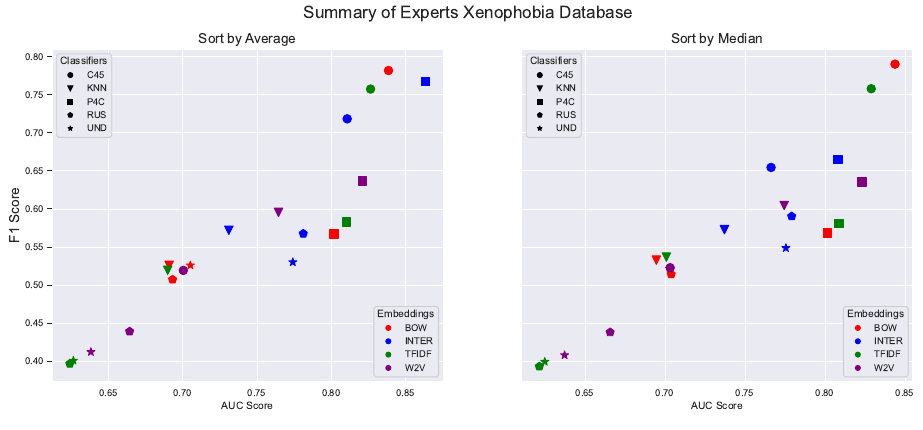
( a ) Results for the Experts Xenophobia Database.